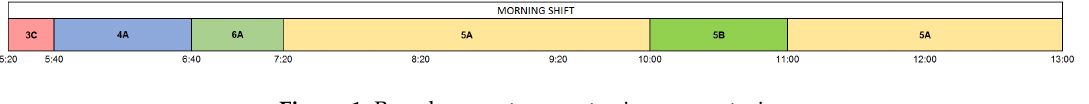
Figure 1. Barcelona eastern route airspace